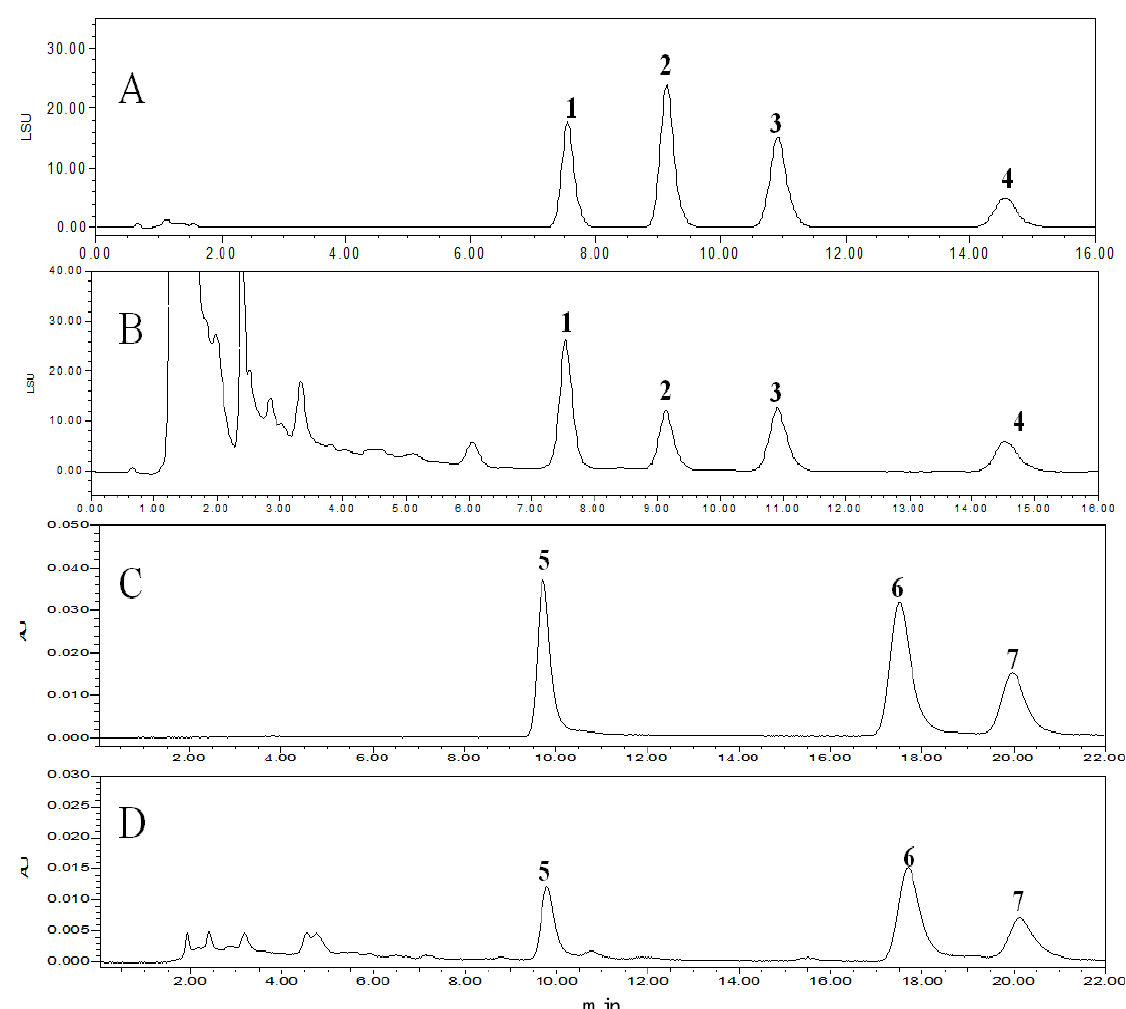
Figure 2. HPLC-ELSD chromatograms of a mixture of terpene lactones standards (A), a sample of G. biloba leaves (B), HPLC-PDA chromatograms of a mixture of flavonol aglycones standards (C) and a sample of G. biloba leaves (D) recorded at 360 nm.